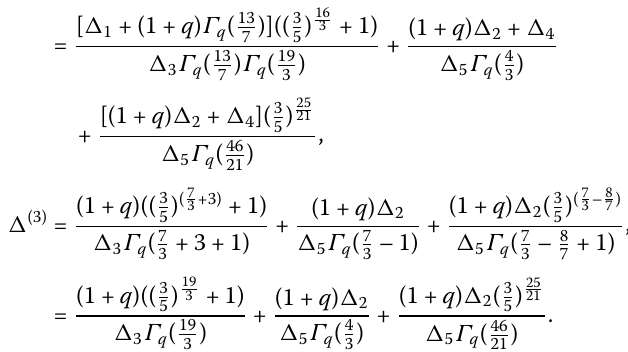
, 1 , 6 in Example 10 2 7